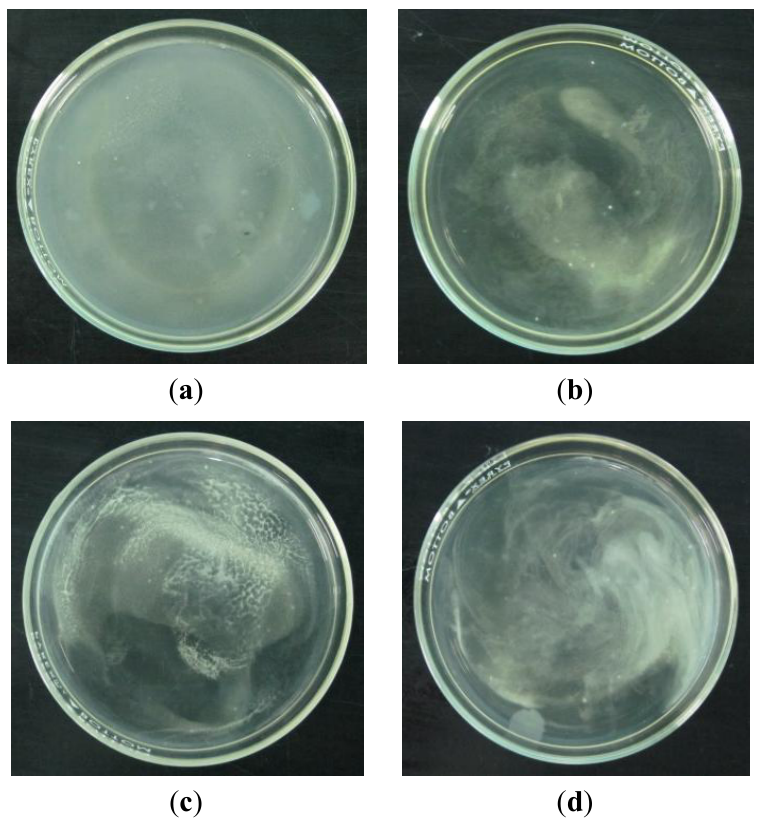
Figure 4. Agar plates containing mixtures of bacterial solution and nanomaterials of